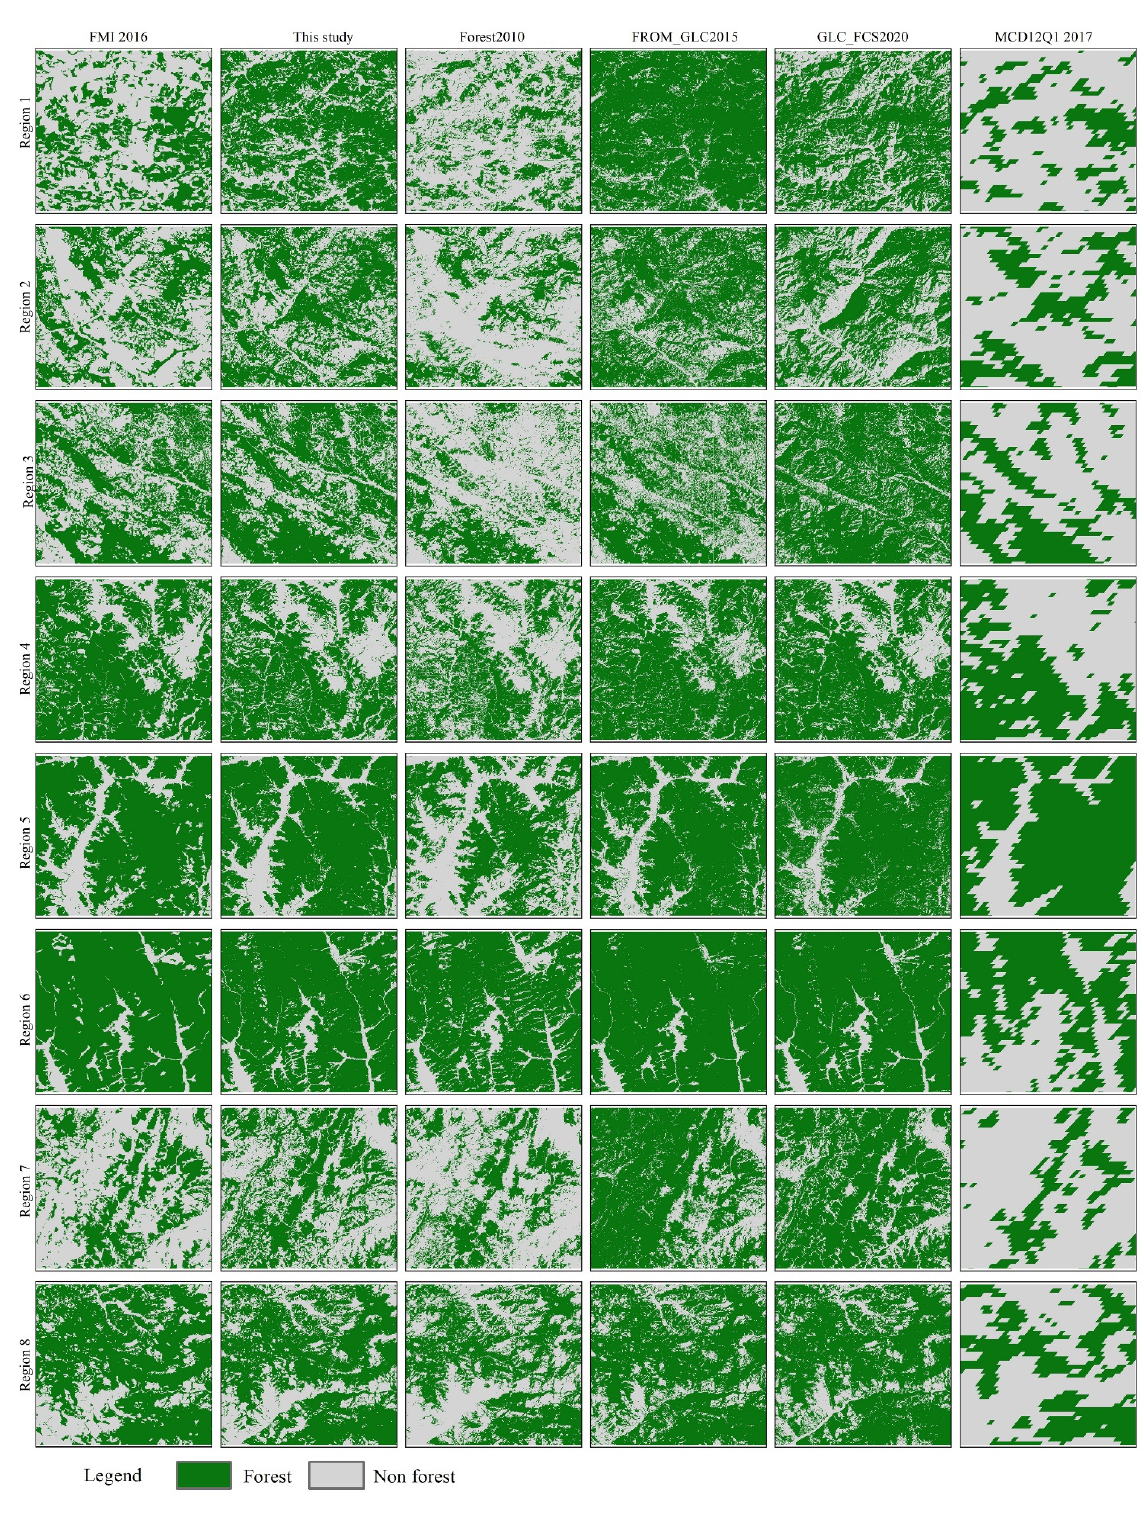
Figure 14. Regional comparison of forest coverage among the product of FMI, this study, Forest 2010, FROM_GLC2015, GLC_FCS2020, and MCD12Q1 2017 over eight case regions. The first column are maps from FMI as a standard.